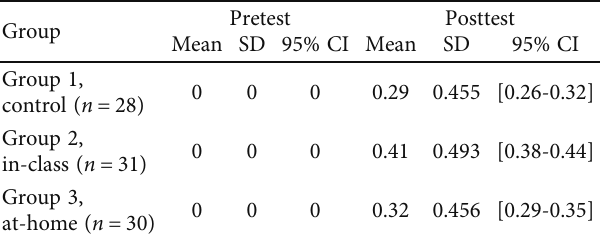
Figure 5: Creswell and Creswell ’ s 6-step model of qualitative analysis. Table 3: Descriptive statistics for the pre-test and post-test.